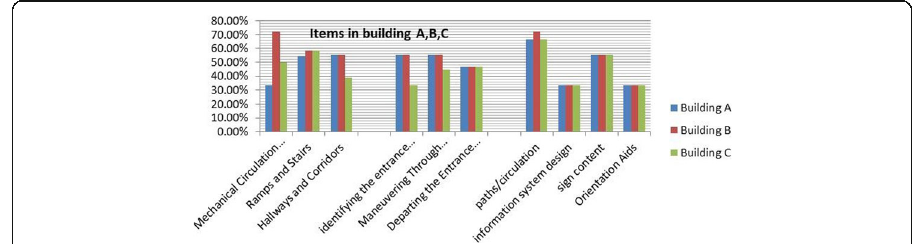
Fig. 24 Percentage of compliance to UD for the detailed items in the three